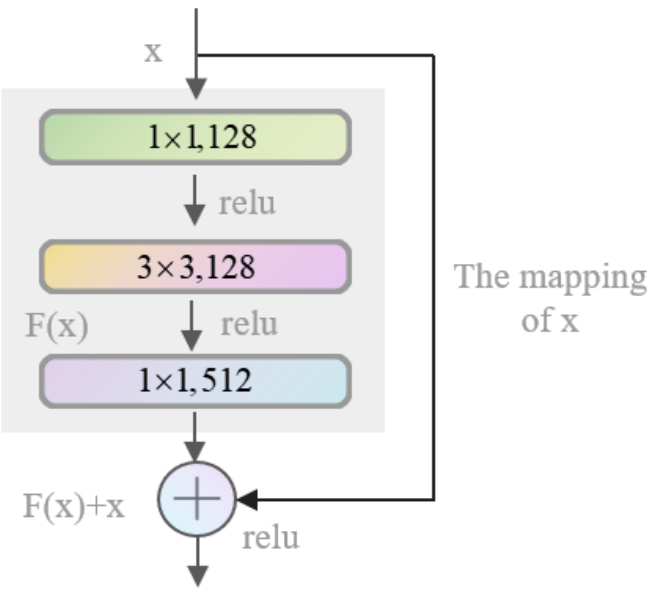
Figure 1. Residual learning module of ResNet.